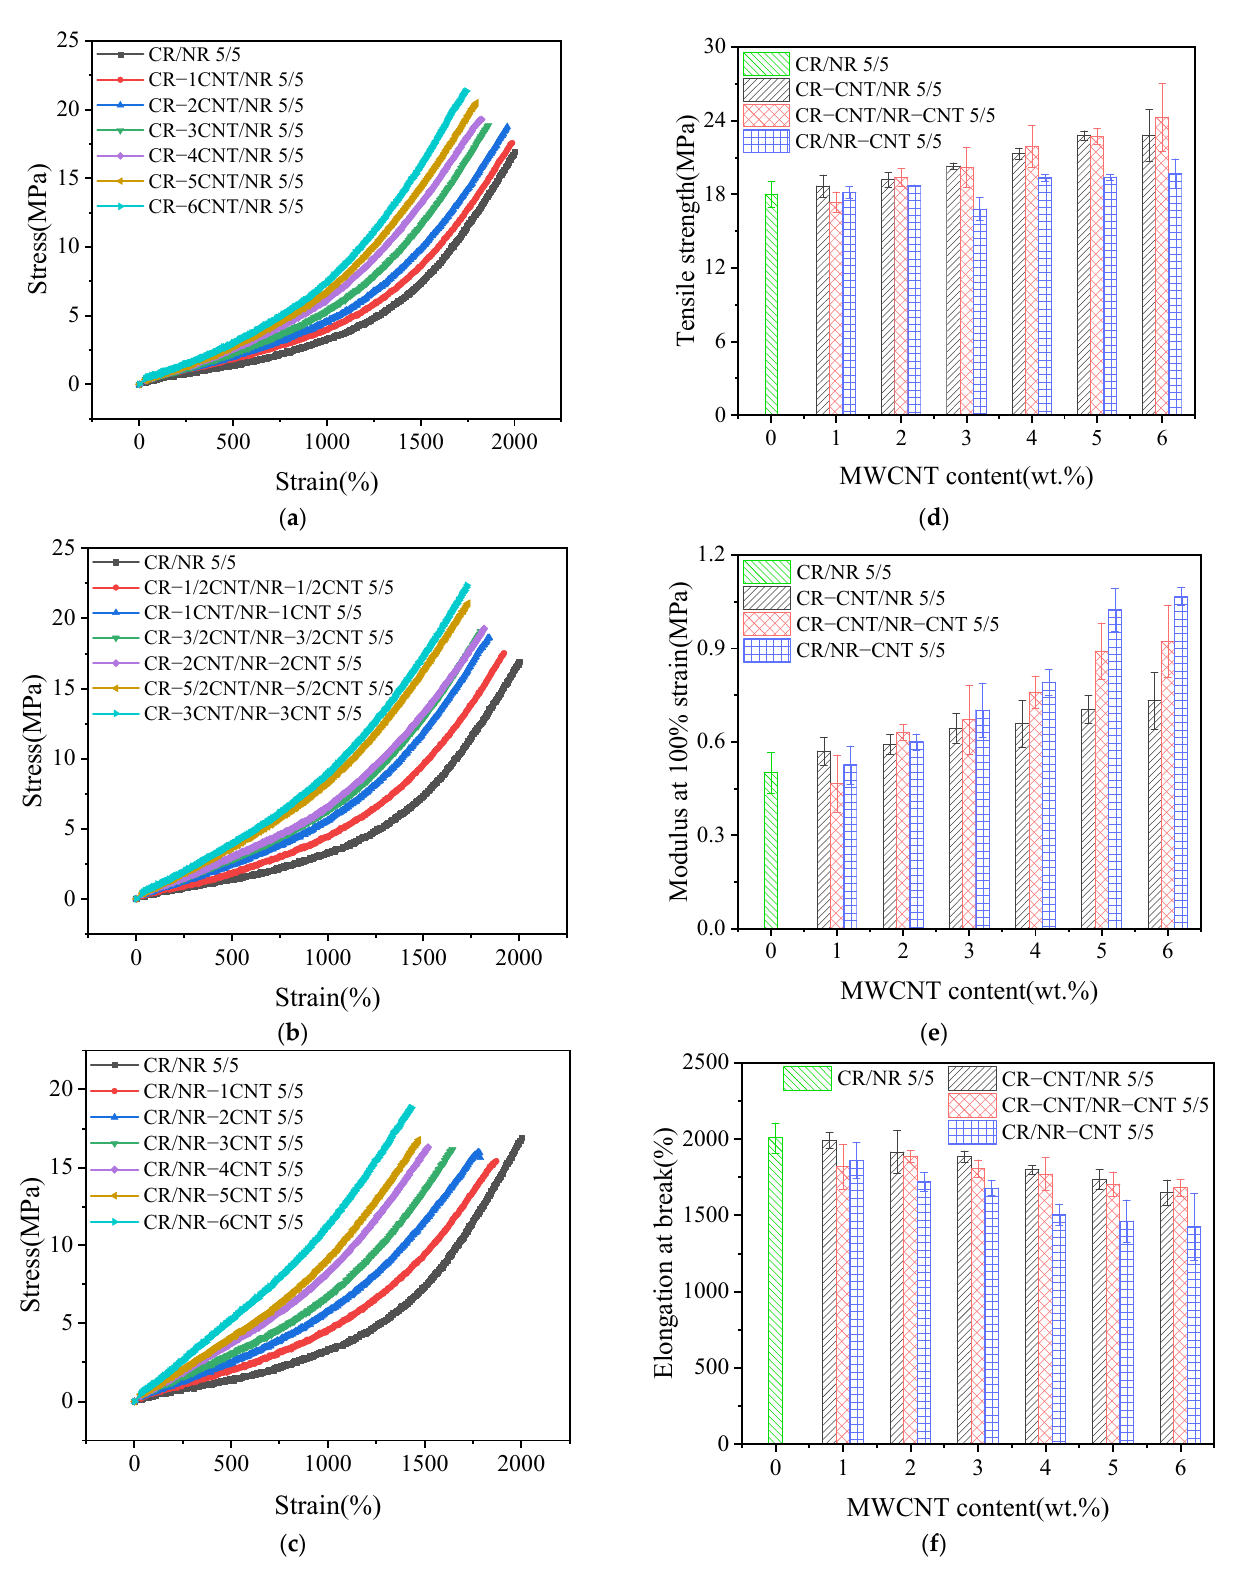
Figure 4. The mechanical properties of MWCNT/CR − NR composites with different blending process: the stress–strain curves (( a ) CR − CNT/NR composites, ( b ) CR − CNT/NR − CNT composites, and ( c ) CR/NR − CNT composites), ( d ) tensile strength, ( e ) modulus at 100% strain, and ( f ) elongation at break.